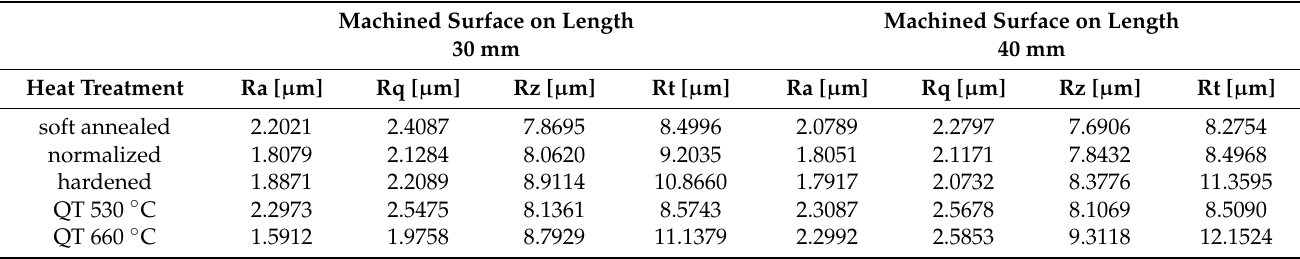
Table 6. Measured roughness parameters of heat treated C45.